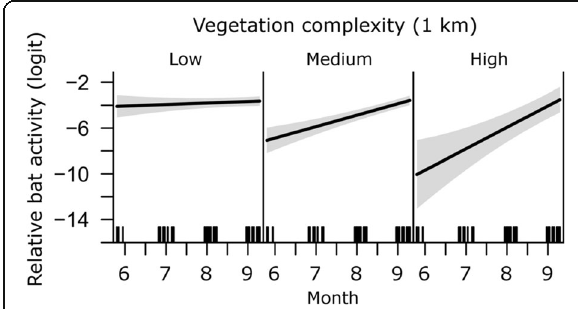
Fig. 4 Effect plot shows how the strength of seasonal variation in the activity of Pipistrellus nathusii varies depending on the vegetation complexity (low, medium, high) within 1 km of the surrounding